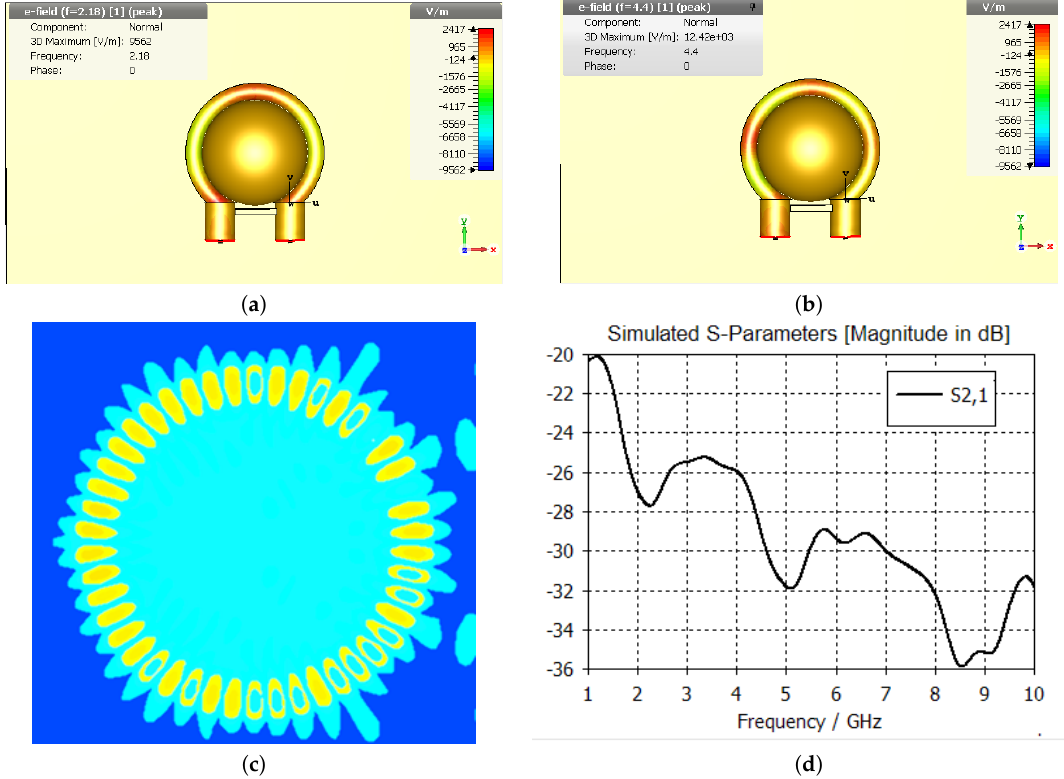
Figure 2. Simulated results ( a ) simulated whispering gallery resonance at 2.18 GHz, ( b ) simulated whispering gallery resonance at 4.4 GHz, ( c ) simulated whispering gallery modes at 56.2 GHz and ( d ) the simulated S-parameters for the proposed experimental